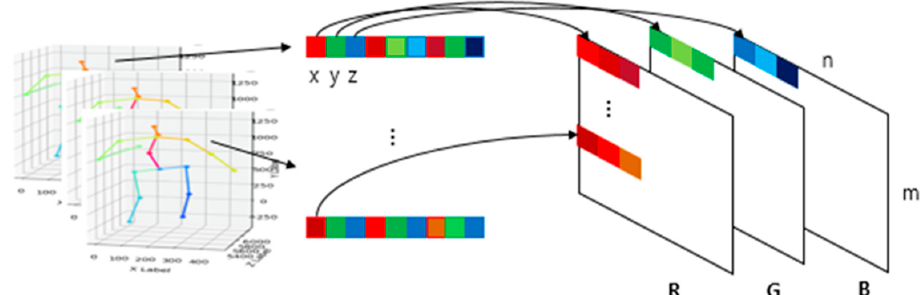
Figure 3. Joint data conversion to RGB image.